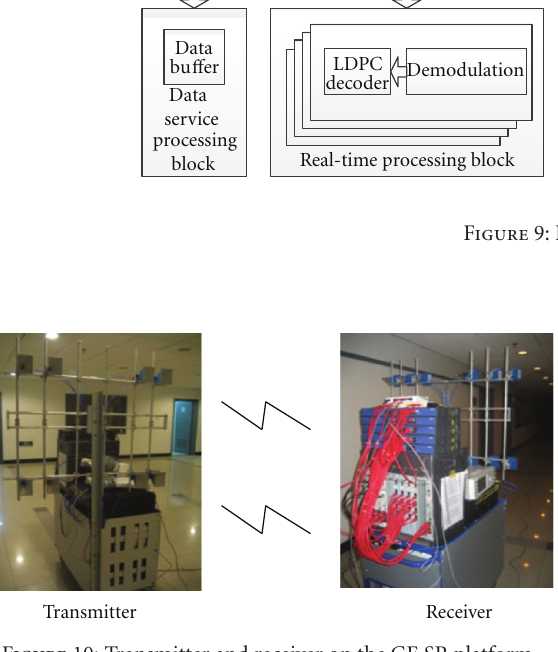
Figure 10: Transmitter and receiver on the GE SR